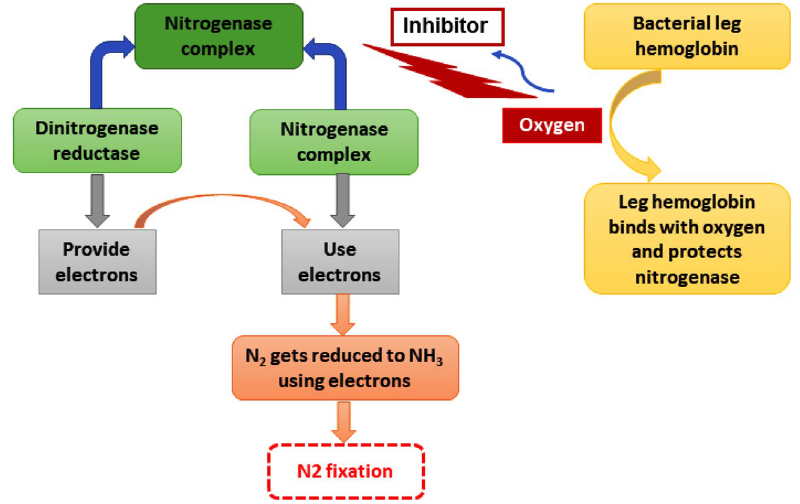
Figure 3. Mechanism of nitrogen fixation bio-catalyzed by nitrogenase enzyme. The plant growth- promoting bacteria produce nitrogenase which is a complex enzyme consisting of dinitrogenase reductase and dinitrogenase. This complex enzyme plays a major role in molecular N 2 fixation. Dinitrogenase reductase provides electrons and dinitrogenase uses those electrons to reduce N 2 to NH 3 . However, oxygen is a potential threat to this process since it has the ability to get bound to the enzyme complex and make it inactive and consequently inhibit the process. Interestingly, bacterial leghemoglobin has a strong affinity for O 2 and thus gets bound to free oxygen more strongly and effectively to suppress the available oxygen effects on the whole process of nitrogen fixation.